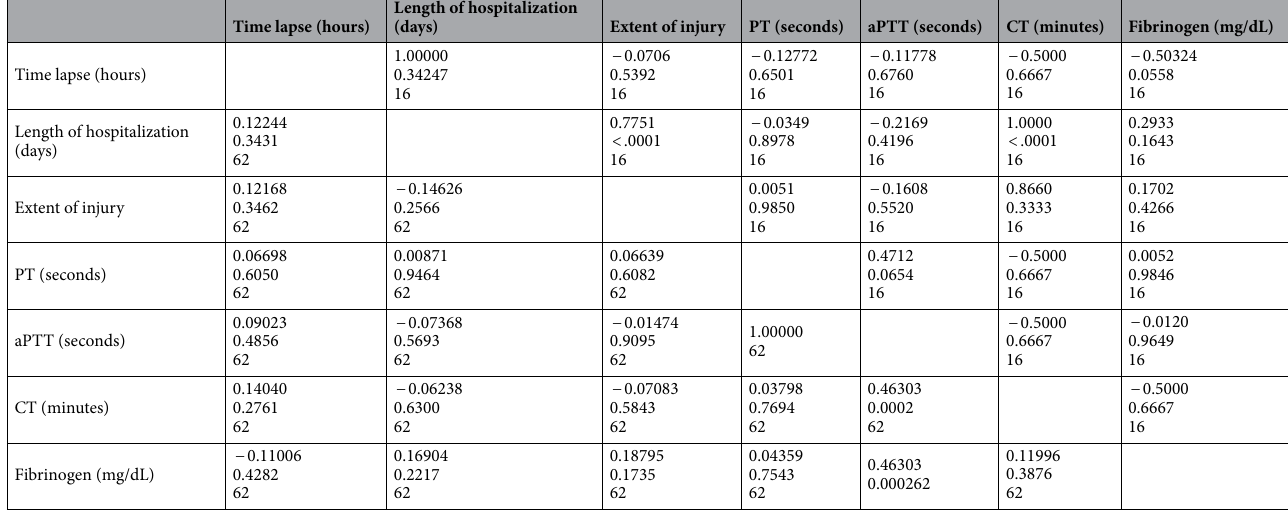
Table 3. Spearman’s rank correlation coefficient ( r s ) between the tested variables from coagulopathic (above diagonal) and non-coagulopathic (below diagonal) dogs. Three values per each pair of variables indicate the r s , corresponding probability and sample size from top to bottom, respectively.